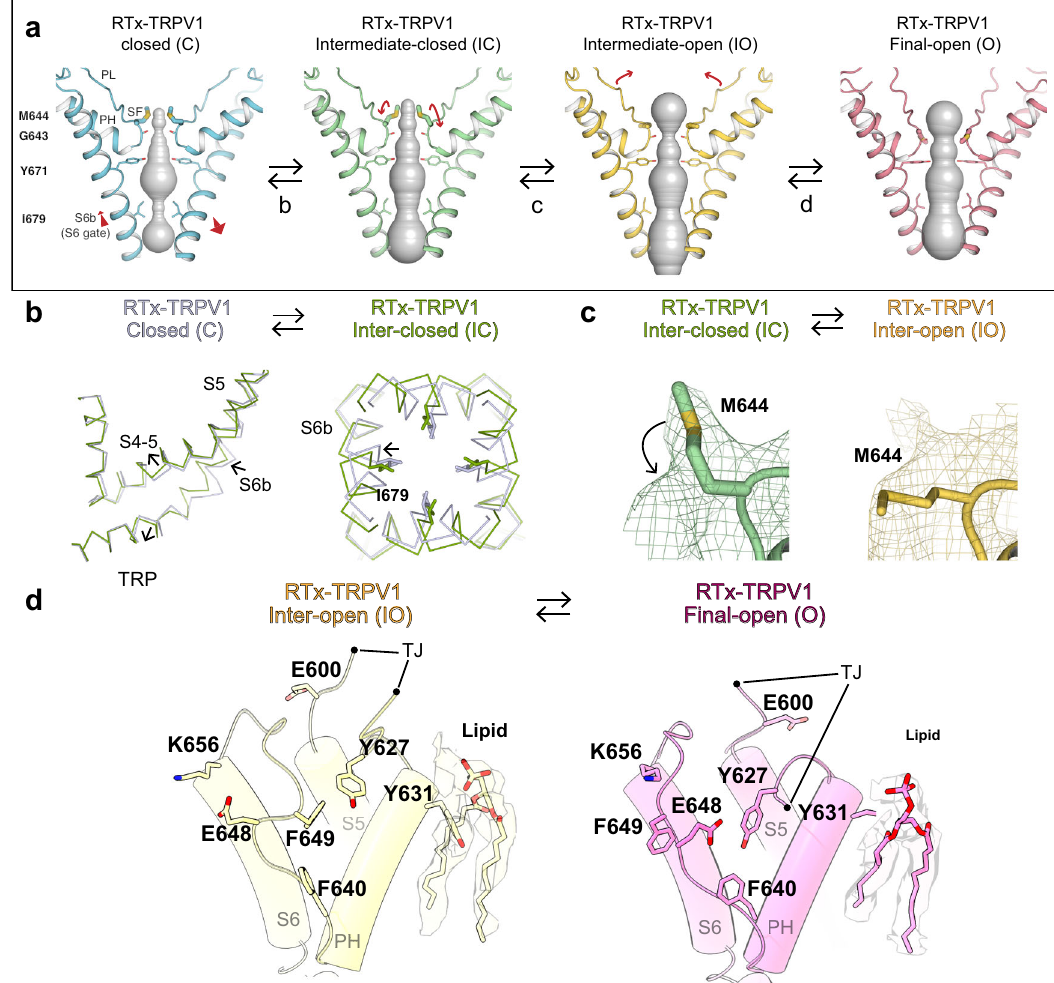
Fig. 3 RTx-dependent conformational trajectory of TRPV1. a Comparison of the pore domain structures, only two subunits are shown for clarity, with the S6 gate (S6b), selectivity fi lter (SF), pore loop (PL) and pore helix (PH) as indicated. The pore pro fi les are shown as surfaces (gray). The red arrows indicate direction of movement. b Comparison of TRPV1 C,RTx (gray) and TRPV1 IC,RTx (green) structures (left) and close-up view of TRPV1 C,RTx and TRPV1 IC,RTx pore region (right). c The cryo-EM densities and the models for M644 in TRPV1 IC,RTx (green) and TRPV1 IO,RTx (gold). The cryo-EM map thresholdings are 0.03, and 0.04, respectively. d Comparison of TRPV1 IO, RTx (gold) and TRPV1 O, RTx (pink) outer pore region. Representative residues showing large motions are shown as sticks. TJ, turret junction. Phospholipids are shown as sticks and cryo-EM densities, with thresholding at 0.035 and 0.029,